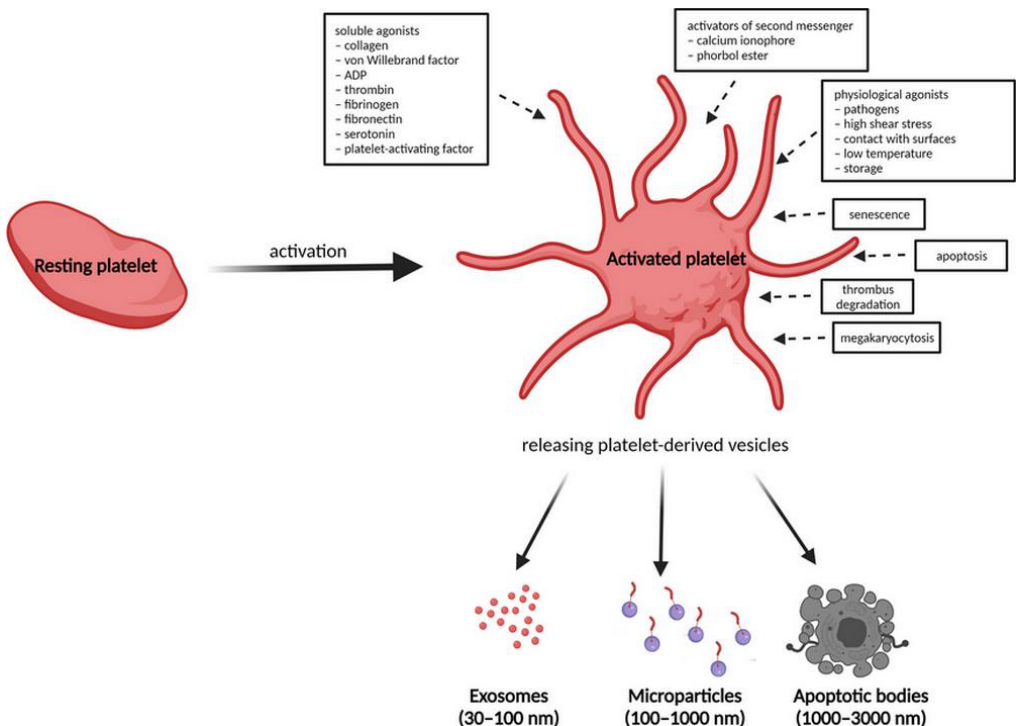
Figure 2. Activation process of anucleated platelets in the blood and release of multiple EVs as a result of morphological and functional changes. (Created with BioRender.com).